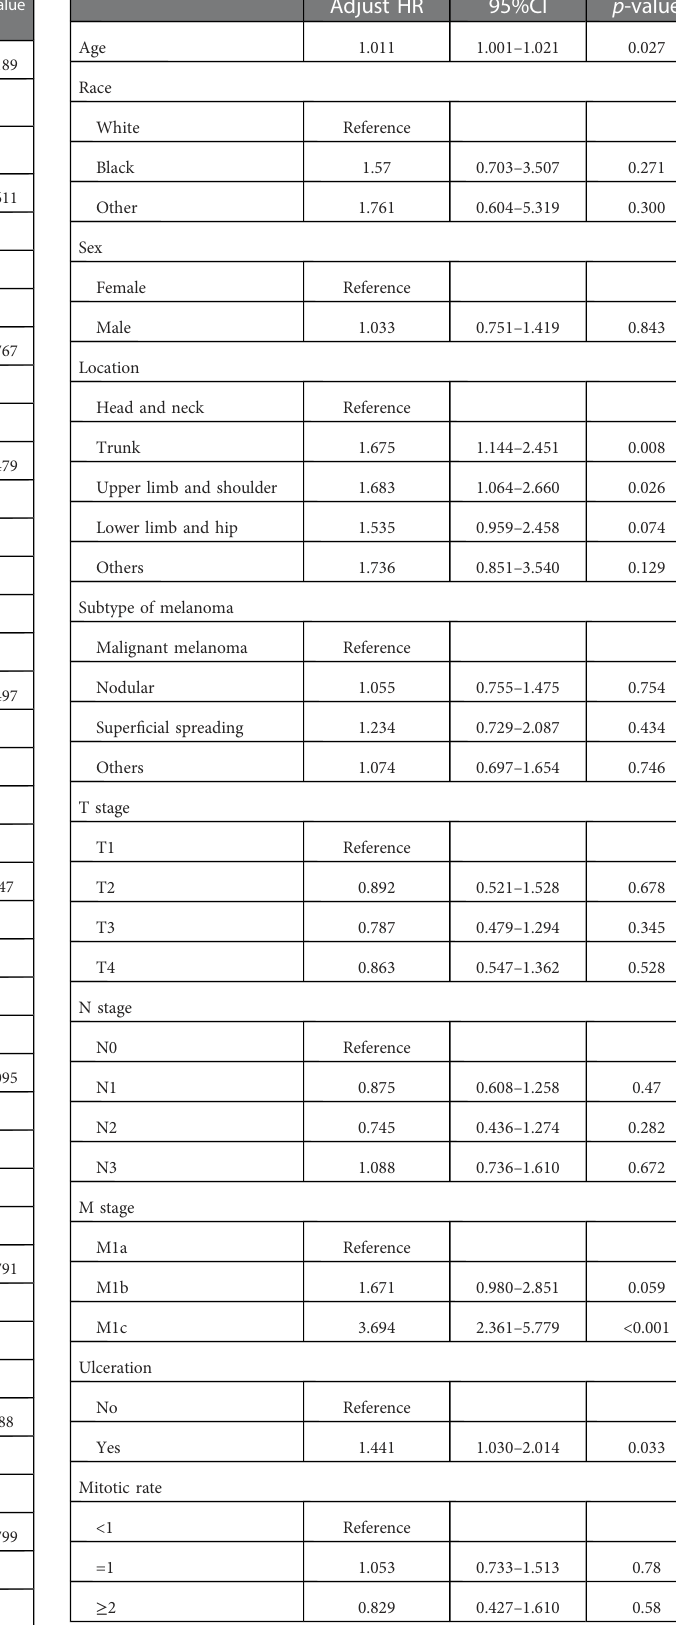
TABLE 2 Clinicopathological characteristics of training set and validation set.